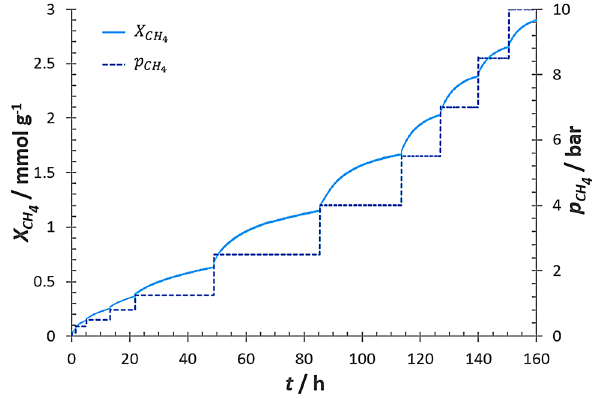
Fig. 12 Time dependent adsorption uptake response induced by a pressure profile of CH Al O core–shell at T = 303.15 K 2 3